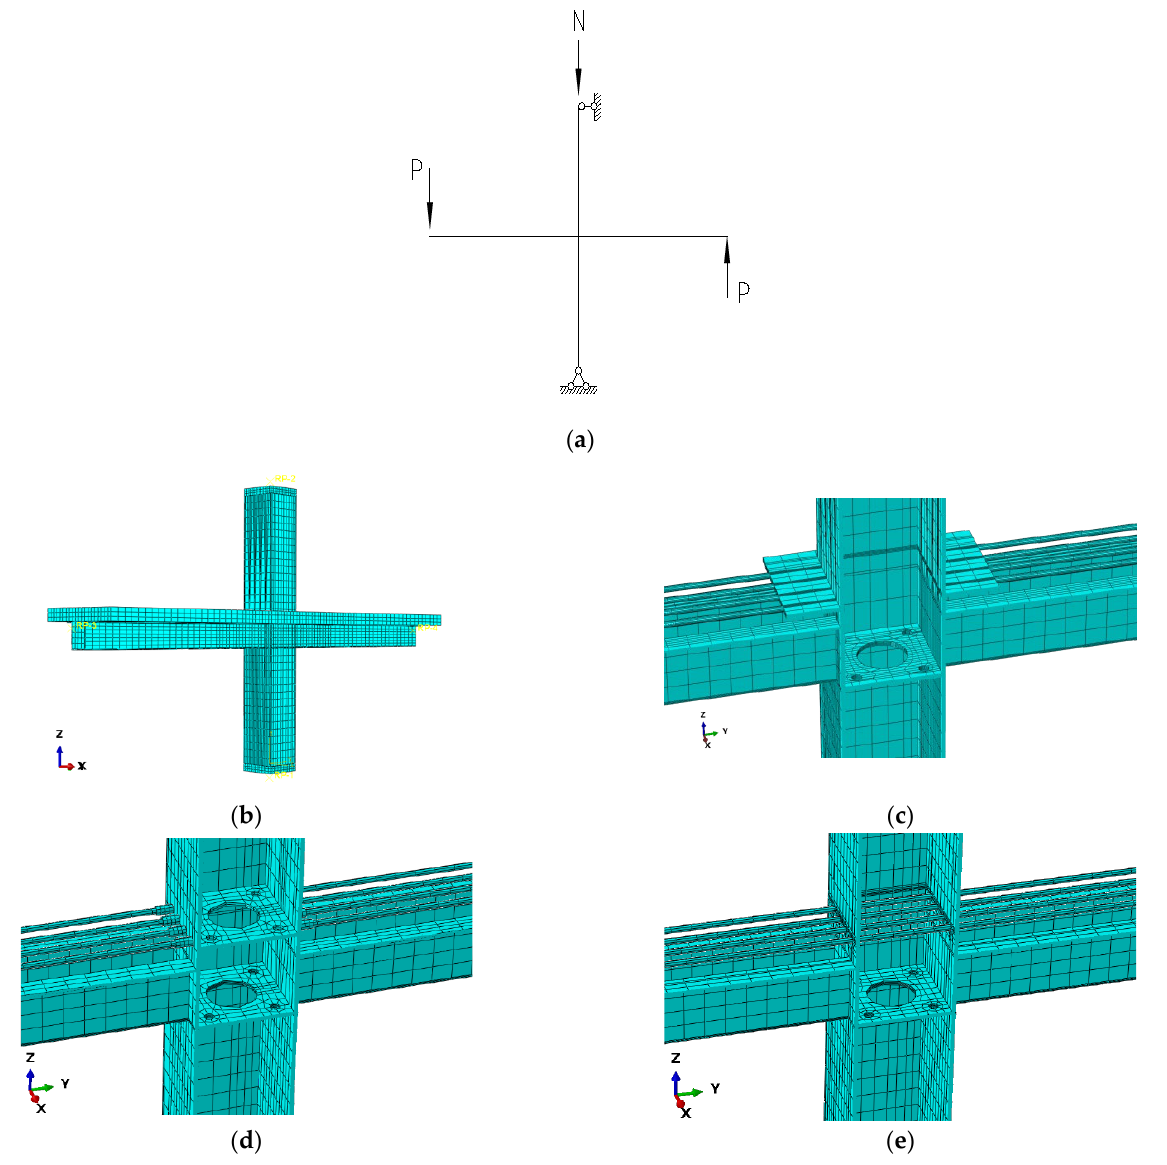
Figure 9. Boundary conditions scheme and finite element models: ( a ) boundary conditions scheme; ( b ) the whole model; ( c ) RP connection; ( d ) RS connection; ( e ) RT connection.